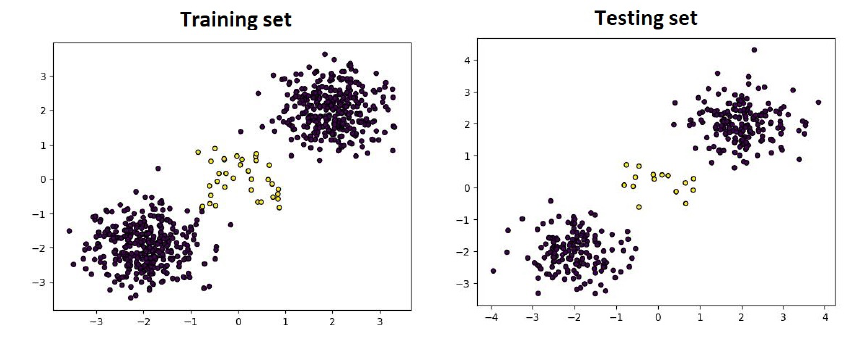
Figure 3. Points from the Normal dataset.